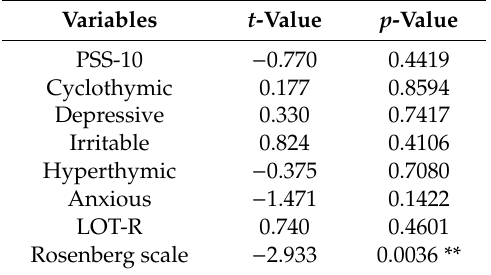
Table 1. Scores obtained on the five dimensions of the Temperament Evaluation of Memphis, Pisa, Paris, and San Diego questionnaire short version (TEMPS-A), the LOT-R scale, and the Rosenberg Self-Esteem Scale in the allopathic medical students and podiatric medical students. Data are reported as mean ± SE. (**) p < 0.01.